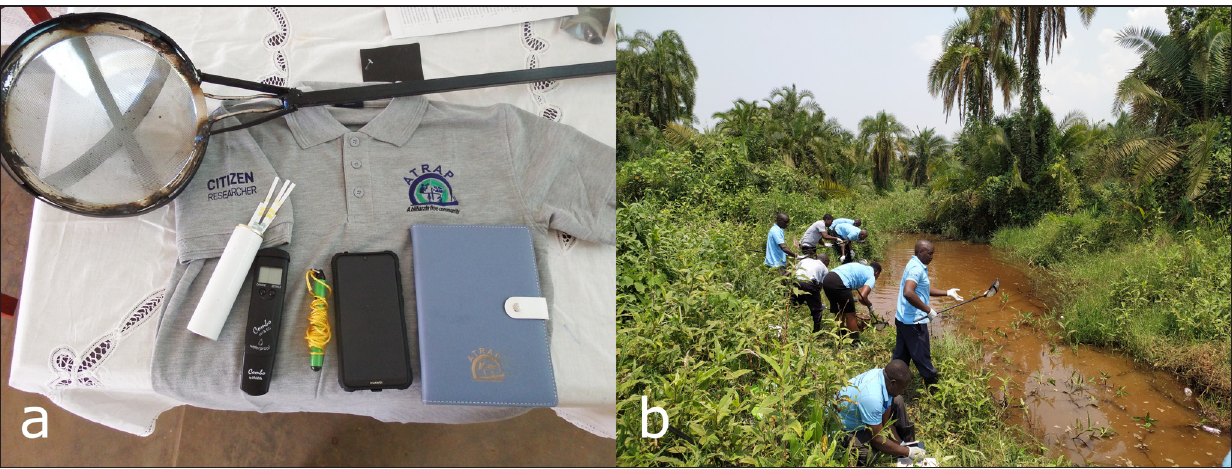
Figure 2 (a) Overview of the equipment provided to the citizen scientists: fine-meshed scoop net, ATRAP project t-shirt, water chemistry test strips, stream thermometer, smartphone, diary and Hanna Instruments pocket tester. Latex gloves, rubber boots and the laminated sheet of millimetre paper are not shown in the photograph. (b) In-field sampling exercise during the two-day training course for the citizen scientists in Kagadi.